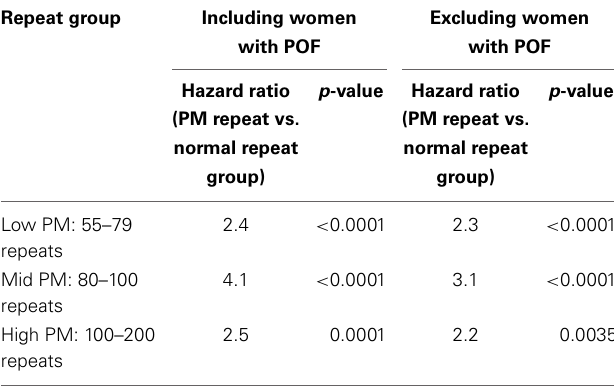
Table 2 | Hazard ratios estimated from Cox proportion hazard model, adjusting for age at interview, race/ethnicity, ever smoked and BMI as covariates.